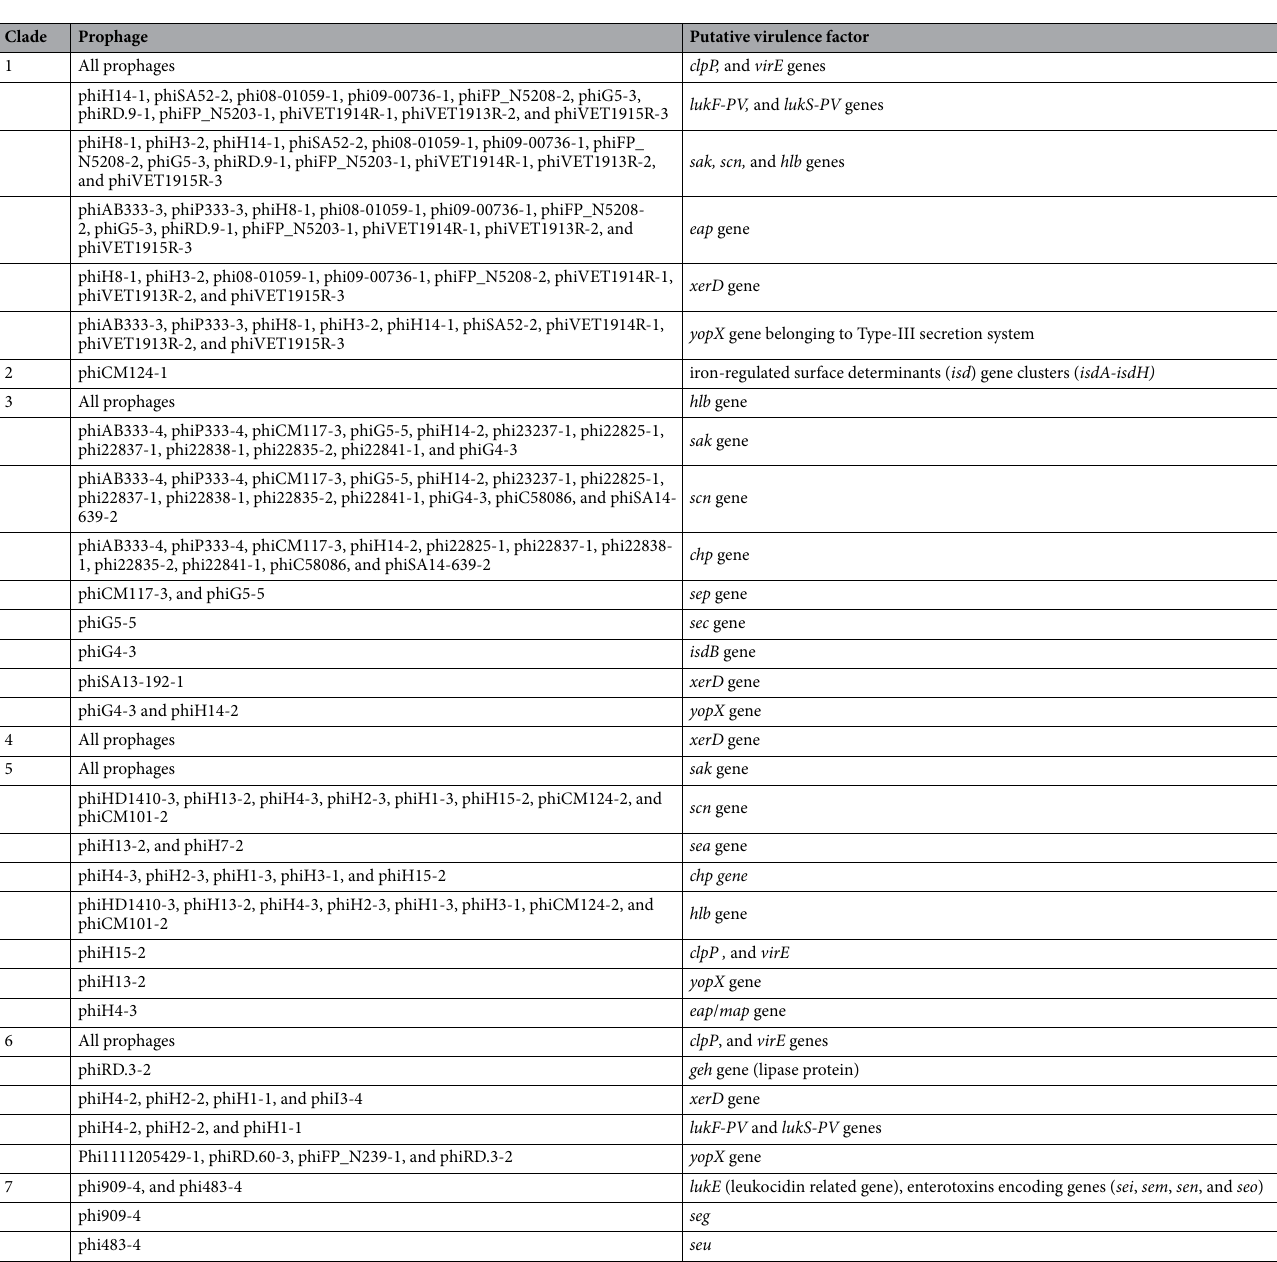
Table 2. Details of the putative virulence factors associated with prophages of S.